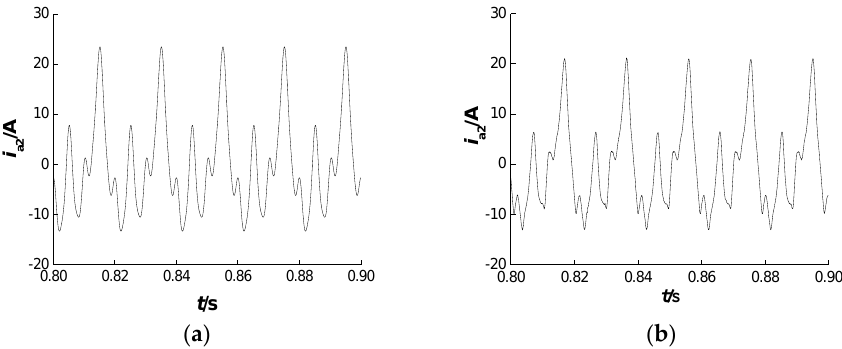
Figure 7. Steady-state waveform in branch a2 under inter-turn circuit of taps 2–4 under load condition connected to power grid. ( a ) Simulation waveform; ( b ) Experimental waveform.